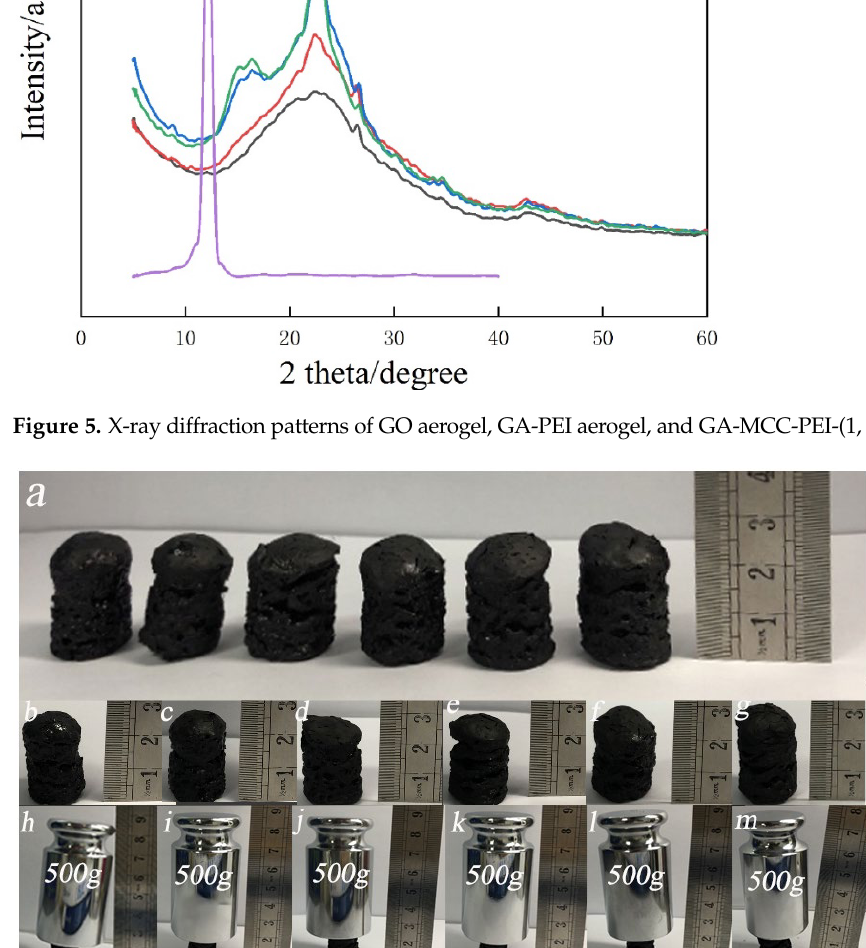
Figure 5. X-ray diffraction patterns of GO aerogel, GA-PEI aerogel, and GA-MCC-PEI-(1, 2, 4) aer- ogels.